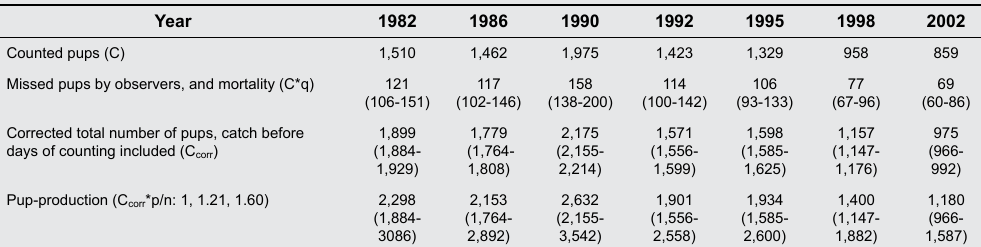
Table 5 . Total pups counted on the coast, from Table 4, corrected for undercounting and catch (conversion factor q + catch prior to date of counting). Estimated pup-production for the Icelan- dic grey seal, in years when counting was achieved in all coastal areas, C corr multiplied with p/n (1.21 log-normally distributed with variance 0.045; log-likelihood 2.330), 95% confidence interval are in